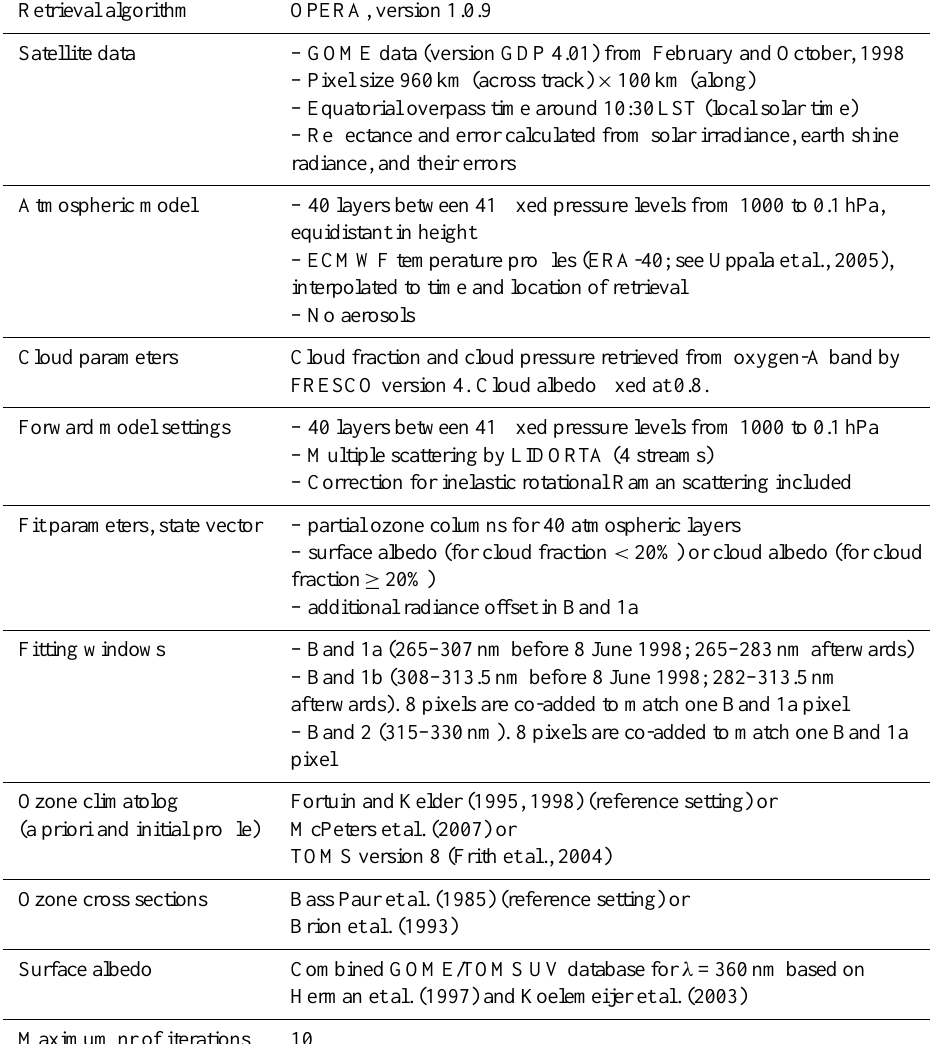
Table 1. Overview of the retrieval settings and input